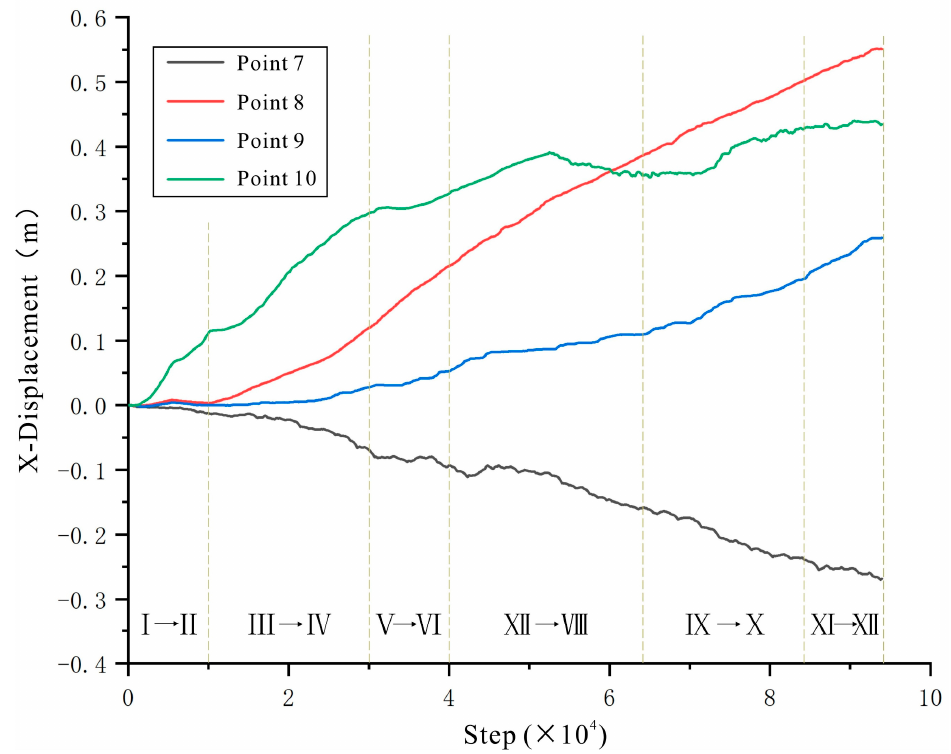
Figure 23. Evolution of the horizontal displacement of the slope surface during sequential mining stages I − XII.